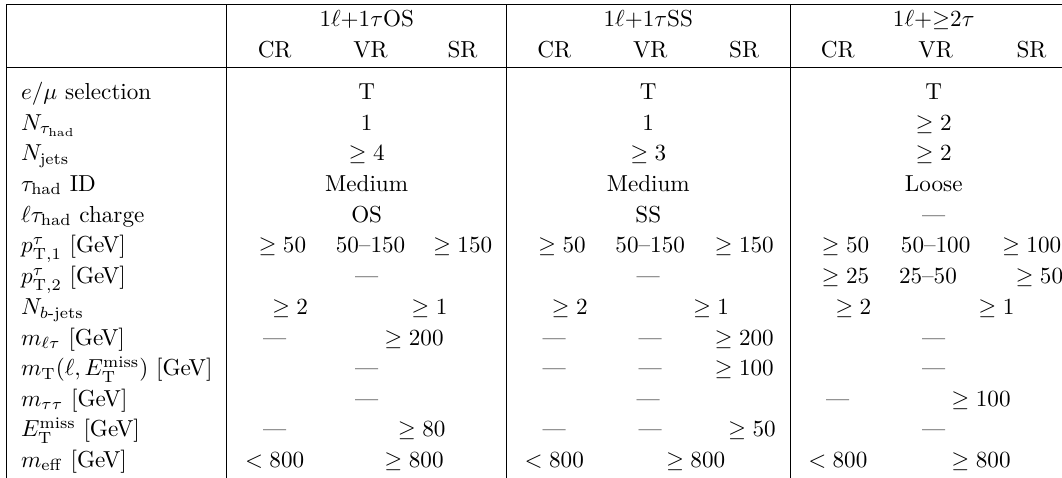
Table 3. Summary of event categories in the 1 ‘ + ≥ 1 τ channel. All events are required to satisfy the preselection requirements. “T” denotes the Tight light-lepton selection criteria (see table 2). The p of the leading and subleading τ candidates are denoted by p τ T had The transverse mass of the system formed by the selected light lepton and the missing transverse momentum is denoted by m ( ‘, E miss ) T T